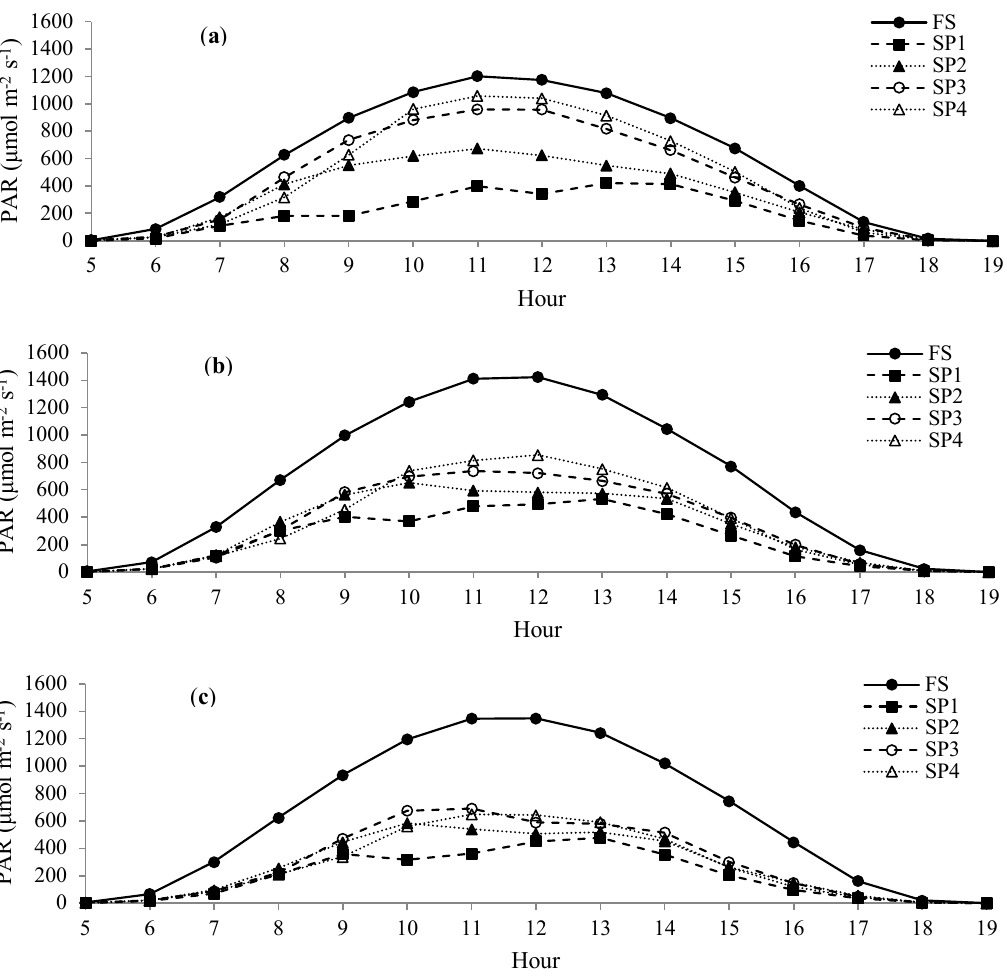
Figure 4. Average photosynthetically active radiation at full sun (FS) and at the four positions within a silvopastoral system (SP1: 0.00 m, SP2: 3.75 m, SP3: 7.50 m and SP4: 11.25 m from the North row),